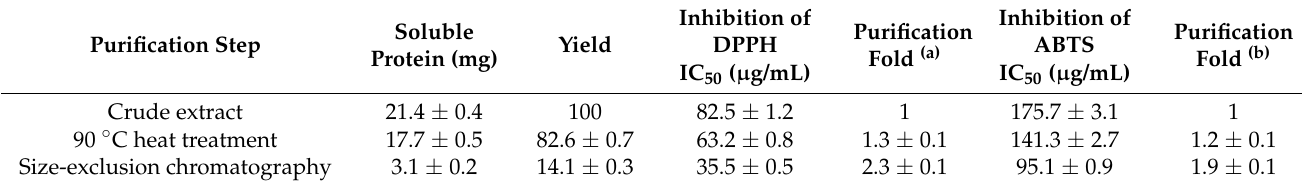
Figure 4. Antioxidant activity of Geoffroea decorticans antioxidant peptides. ( A ) DPPH radical-scavenging activity. ( B ) ABTS radical-scavenging activity. The vertical bars correspond to the standard deviation of three independent measurements ( n = 3). Table 1. Purification steps and antioxidant activity of GdAPs from Geoffroea decorticans seeds.